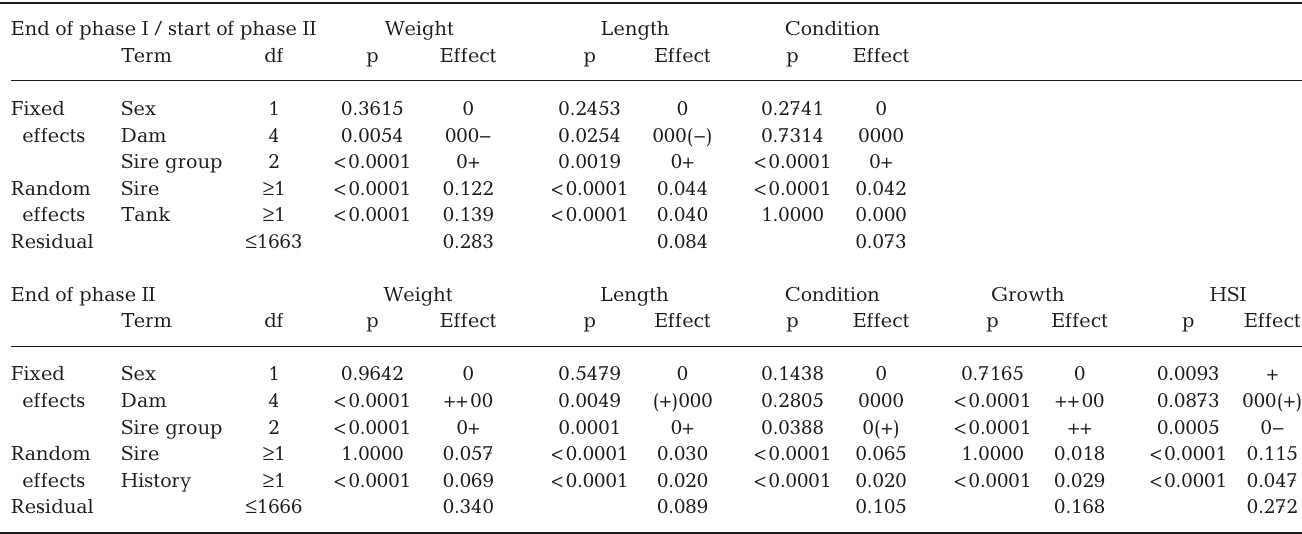
Table 3. Results of the statistical analyses with mixed models in Expt B. For fixed effects, ‘effect’ indicates the significance of individual factor levels relative to the wild Northeast Arctic cod (NEA, for dam and sire group) or females (for sex); symbols are as in Table 1. The or- der of individual dams is ‘D1-1, D1-2, D1-3, D1-4’ and types of sire is ‘D1, D2’ (see Table 1 for descriptions of groups). For random effects, ‘effect’ is the corresponding standard deviation; residual standard deviation is shown for reference. Growth is measured as specific growth rate, with log(start weight) as an additional explanatory variable to account for growth declining with initial size (p < 0.0001). Hepatosomatic index (HSI) shows strong positive allometry and is modeled as gutted-weight dependent liver weight (see ‘Materials and methods’); the estimated allometric exponent is 2.04 (SE